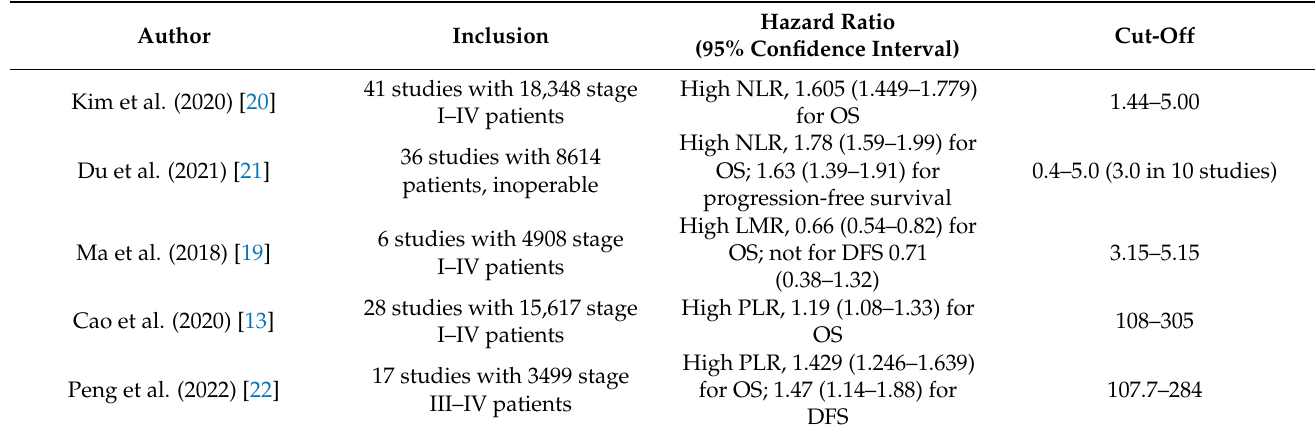
Table 6. Meta-analyses that investigated the prognostic significance of systemic inflammatory markers in stomach